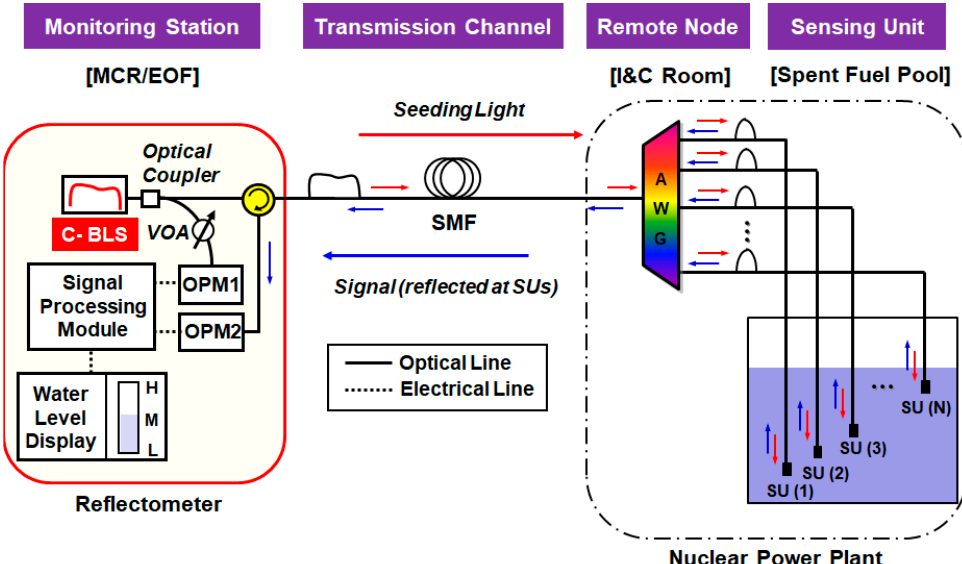
Figure 1. Architecture of the dense wavelength division multiplexing (DWDM)-passive optical fiber sensor network based on single-path configuration. VOA: Variable Optical Attenuator, SU: Sensing Unit, MCR: Main Control Room, EOF: Emergency Operation Facility.